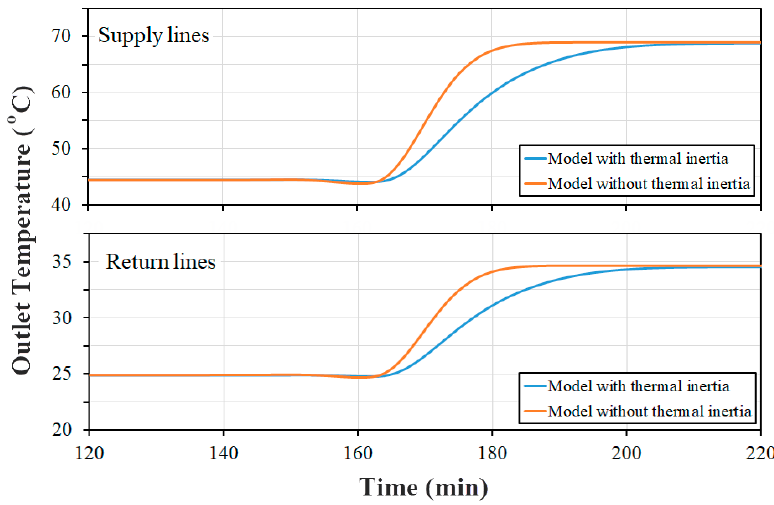
Figure 15. The effect of thermal inertia on the outlet temperature of the Variable-temperature district heating (VTDH) system .